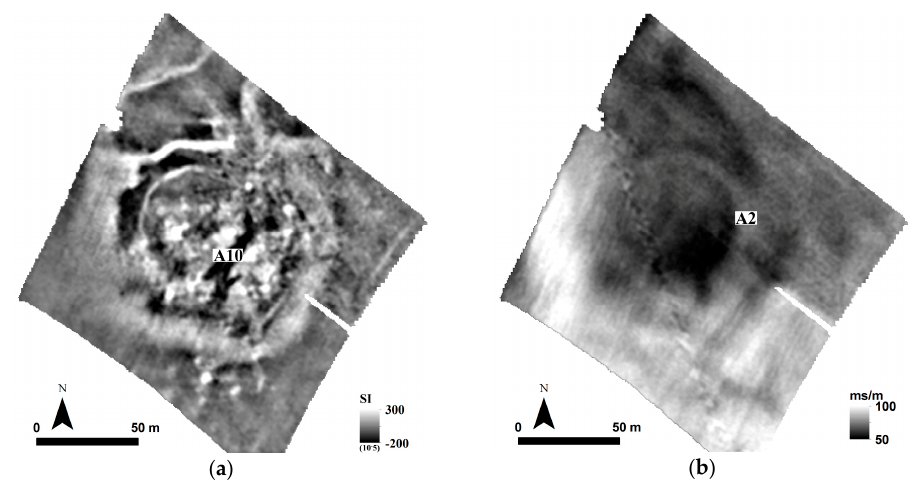
Figure 4. Magnetic susceptibility ( a ); and electromagnetic conductivity ( b ) results from Almyros 2.